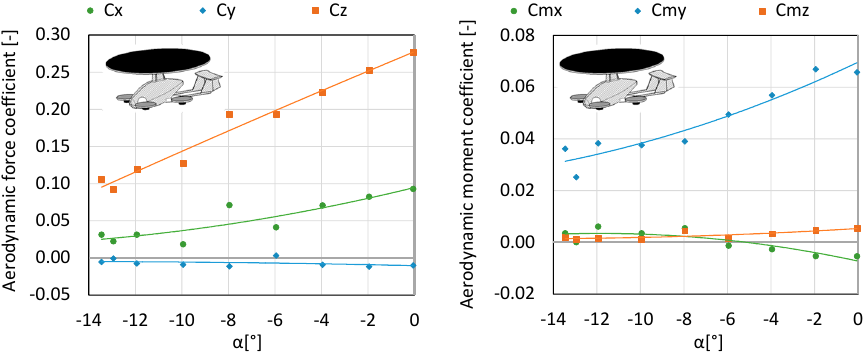
Figure 5. Characteristics of coefficients of forces and aerodynamic moment for configuration K1.